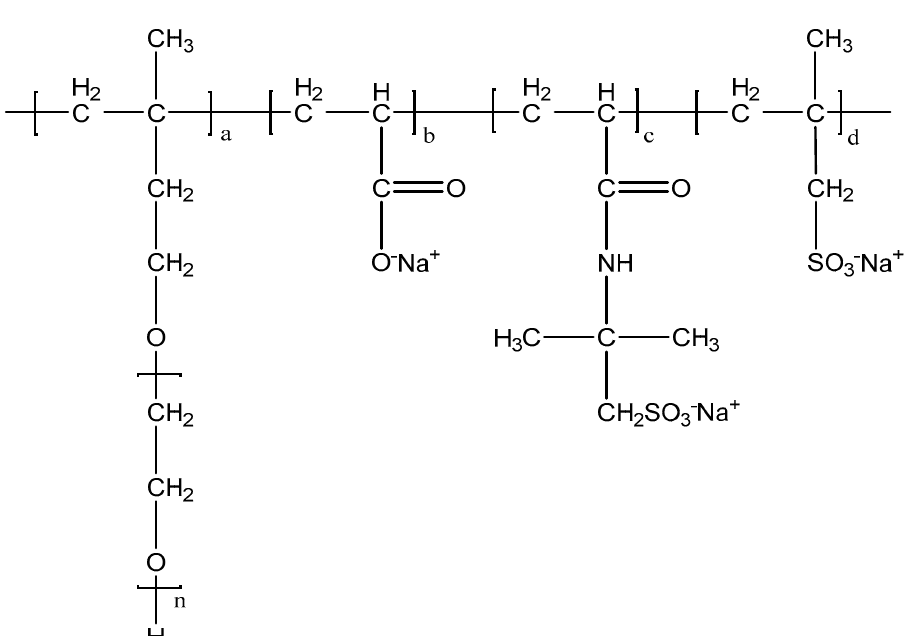
Figure 3. Molecular formula of early-strength polycarboxylic acid superplasticizer Z.